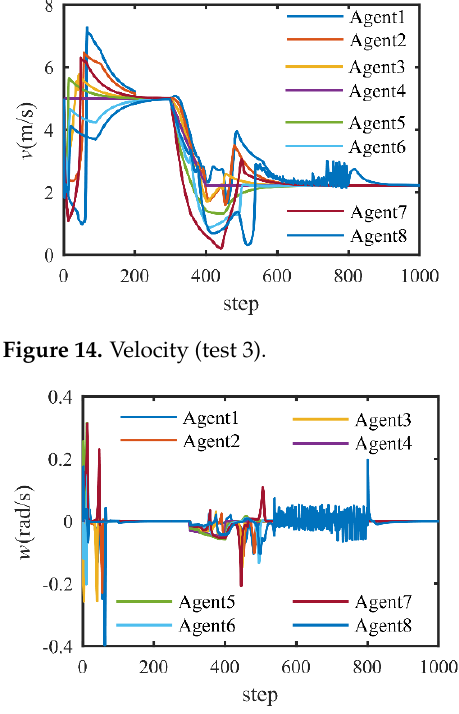
Figure 15. Angular rate (test 3).